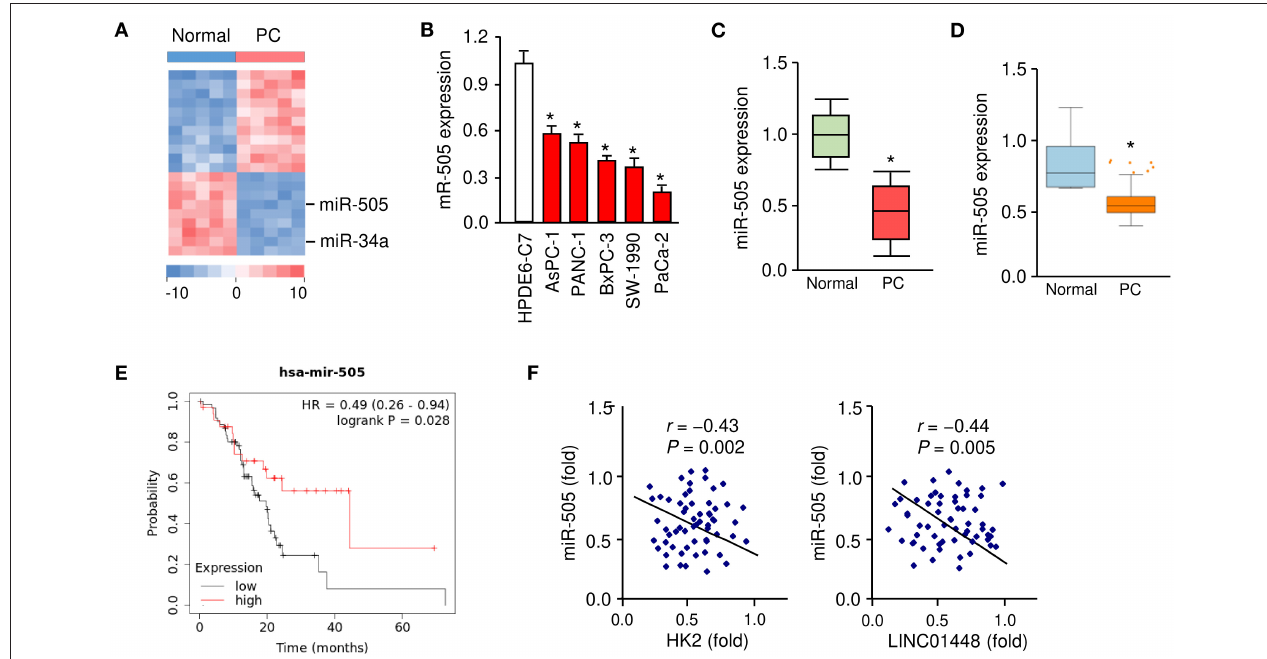
FIGURE 1 | Downregulation of miR-505 in PC tissues and cell lines. (A) The differentially expressed miRNAs between five PC tissues and their adjacent normal tissues were identified using a miRNA microarray analysis. (B) qRT-PCR analysis of miR-505 expression in PC cell lines and a normal pancreatic cell line HPDE6-C7. (C) miR-505 levels in PC tissues and normal tissues were examined using qRT-PCR assays. (D) Meta-profiling of differential expression of miR-505 in PC tissues and normal tissues (MIR-TV database). (E) Kaplan-Meier curves revealed that lower expression of miR-505 was related to poor overall survival in PC patients (KM Plotter database). (F) Correlative analysis of miR-505 and HK2/LINC01448 expression in PC tissues. * P <